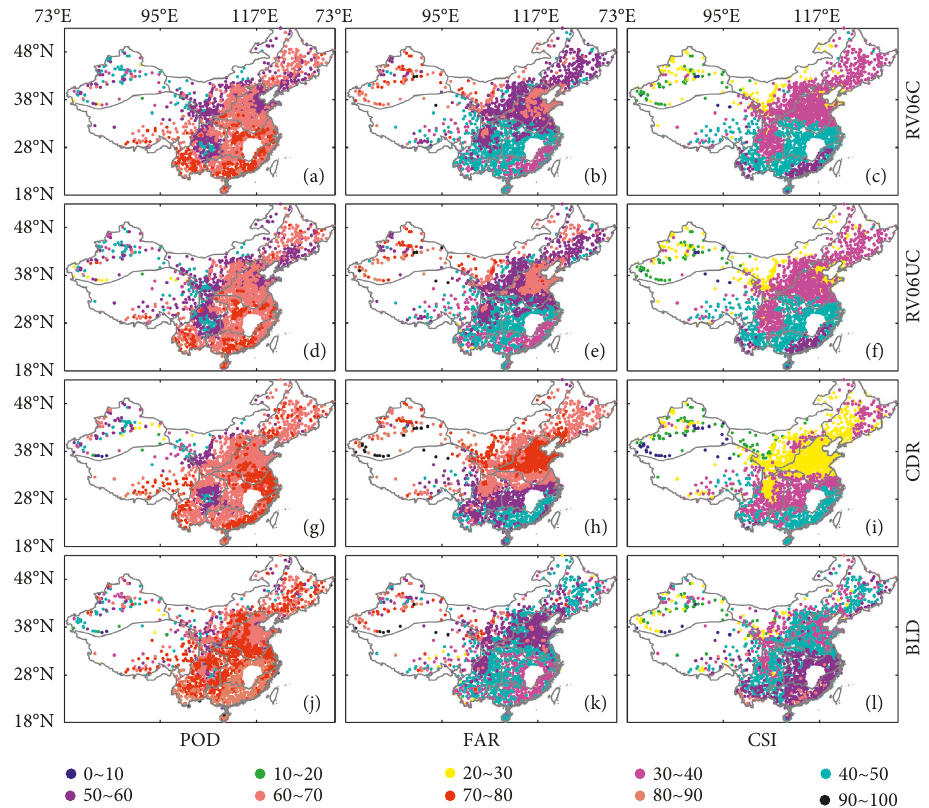
Figure 7: Spatial distribution of categorical statistical indices (POD, FAR, and CSI) for RV06C (first row), RV06UC (second row), CDR (third row), and BLD (fourth row), as compared to precipitation gauges’ measurements derived from March 2014 and June 2018 over Mainland